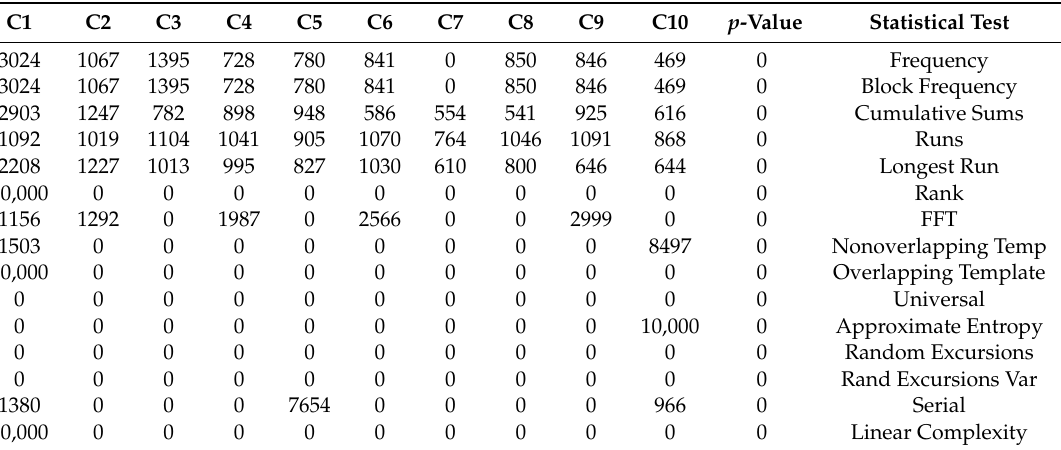
Figure 7. Uniformity of the RC pairs on the third run. Table 4. NIST SP 800-22 Test